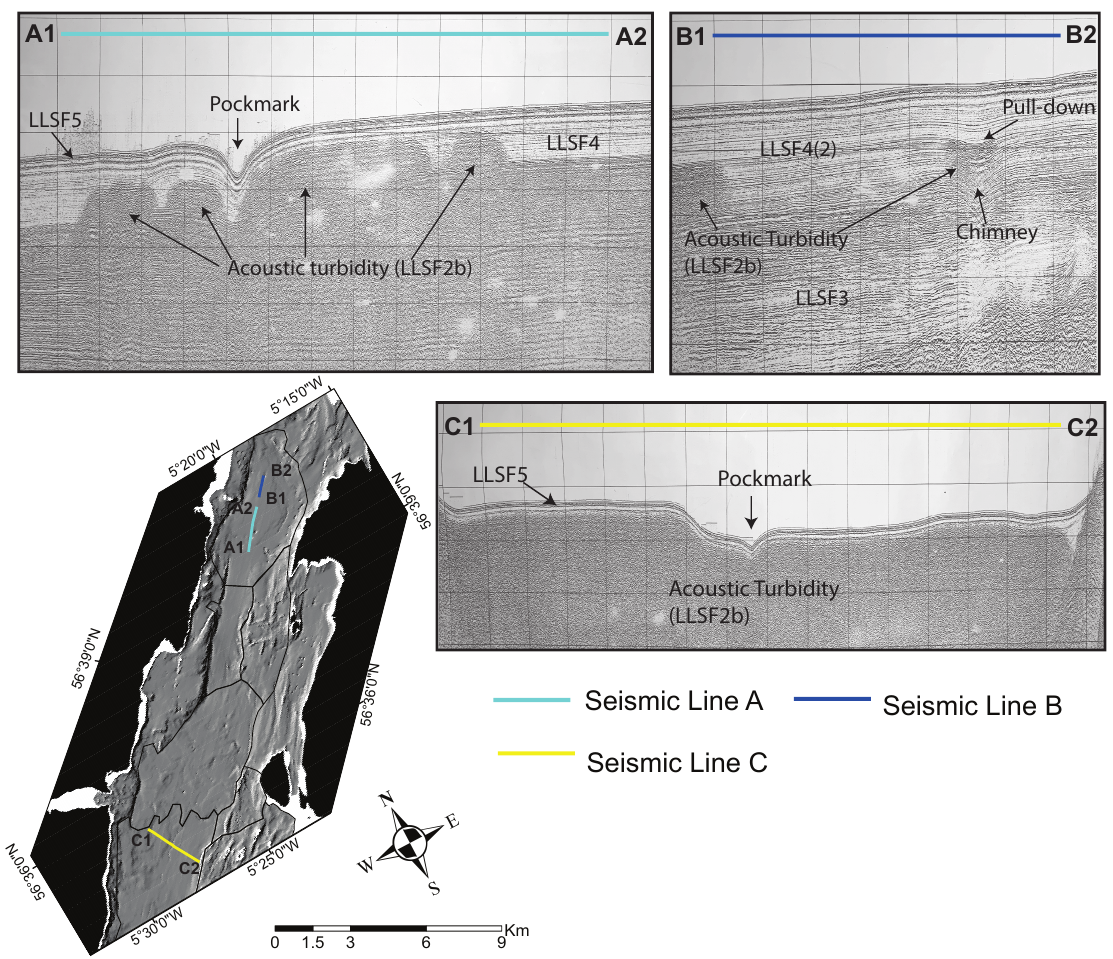
Figure 3. Selected Loch Linnhe seismic lines containing evidence of sub-seabed gas/fluid accumulation in the form of acoustic turbidity (or blanking), seismic chimneys and pull-down reflectors. Map shows the position of seismic lines and corresponding profiles (colour